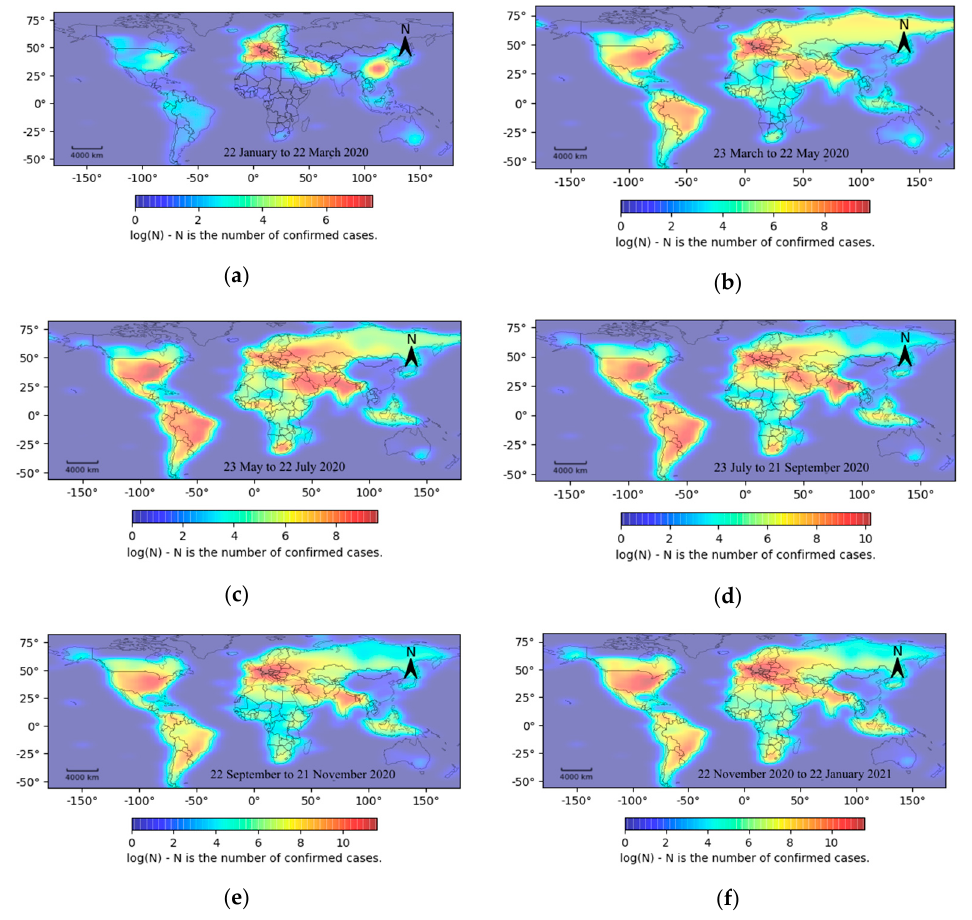
Figure 1. Evolution characteristics in heat maps of the COVID-19 pandemic: ( a ) the heat map of the global pandemic from 22 January to 22 March 2020; ( b ) the heat map of the global pandemic